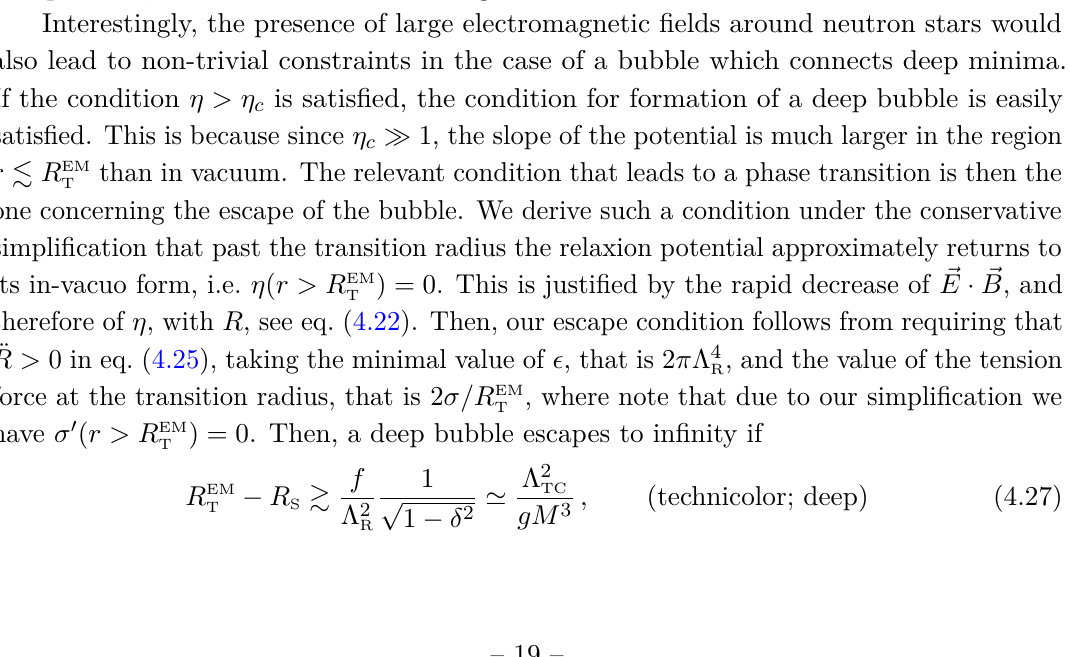
’ Λ . The red R TC for the corresponding decay con- S ’ Λ ) between the two TC R